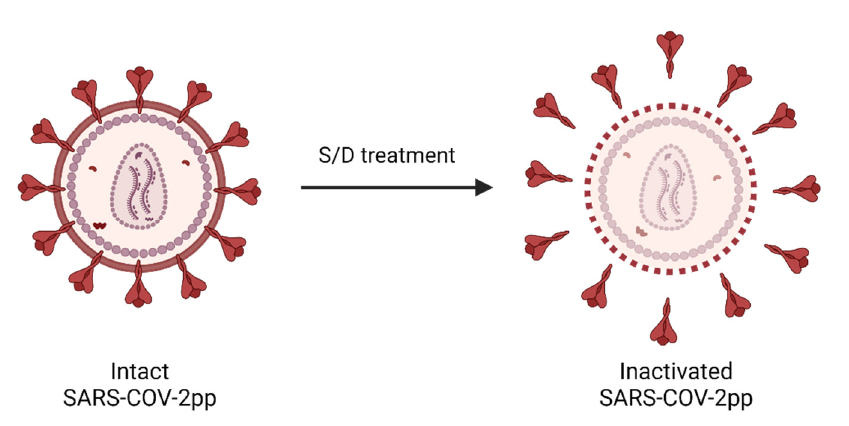
Figure 5. Schematic illustration of S/D treatment’s impact on inactivating SARS-CoV-2pp. The intact lentivirus-based SARS-CoV-2pp is inactivated after S/D treatment, which disrupts the lipid membrane of enveloped viruses, thus destabilizing particle integrity and preventing viral infection. Created with BioRender.com.